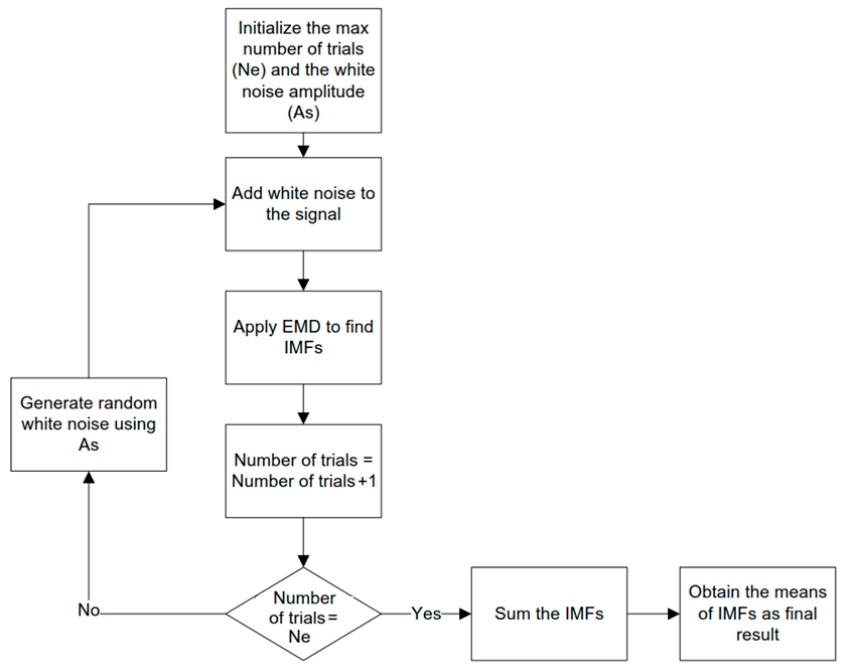
Figure 2. The EEMD procedure (IMF: intrinsic mode functions).